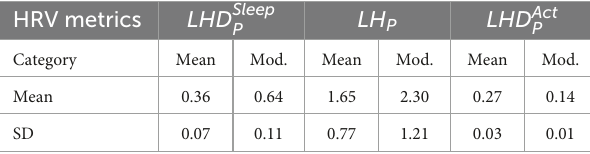
TABLE 4 Mean and standard deviation for three HRV parameters in a case of BFI =